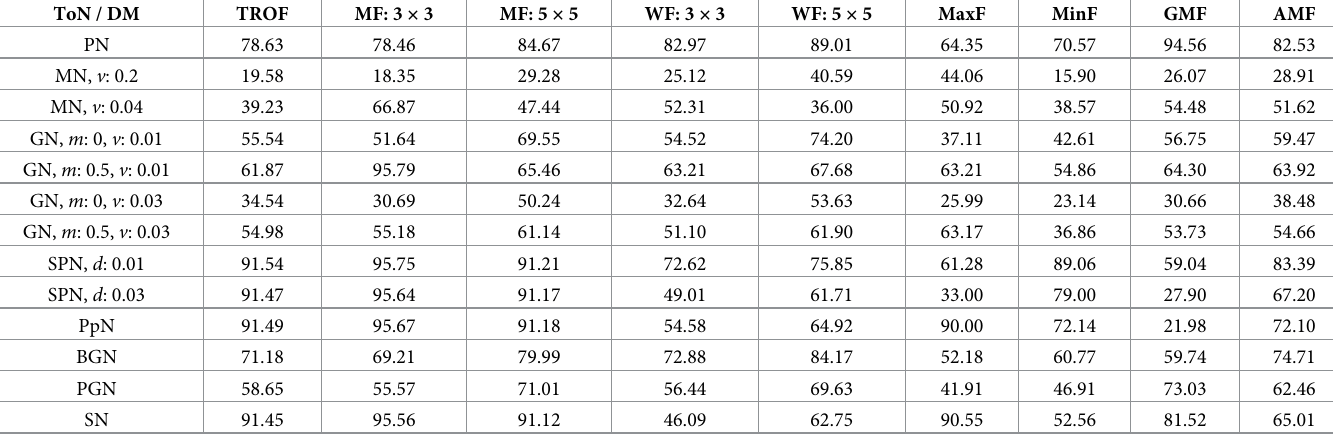
Table 5. A comparison of SSIM between denoised images and original image using EMDS-5. (In [%].). ToN / DM